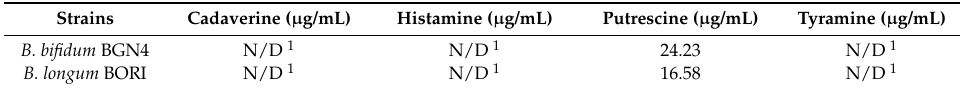
Table 2. Biogenic amine levels of B. bifidum BGN4 and B. longum BORI. Strains Cadaverine ( µ